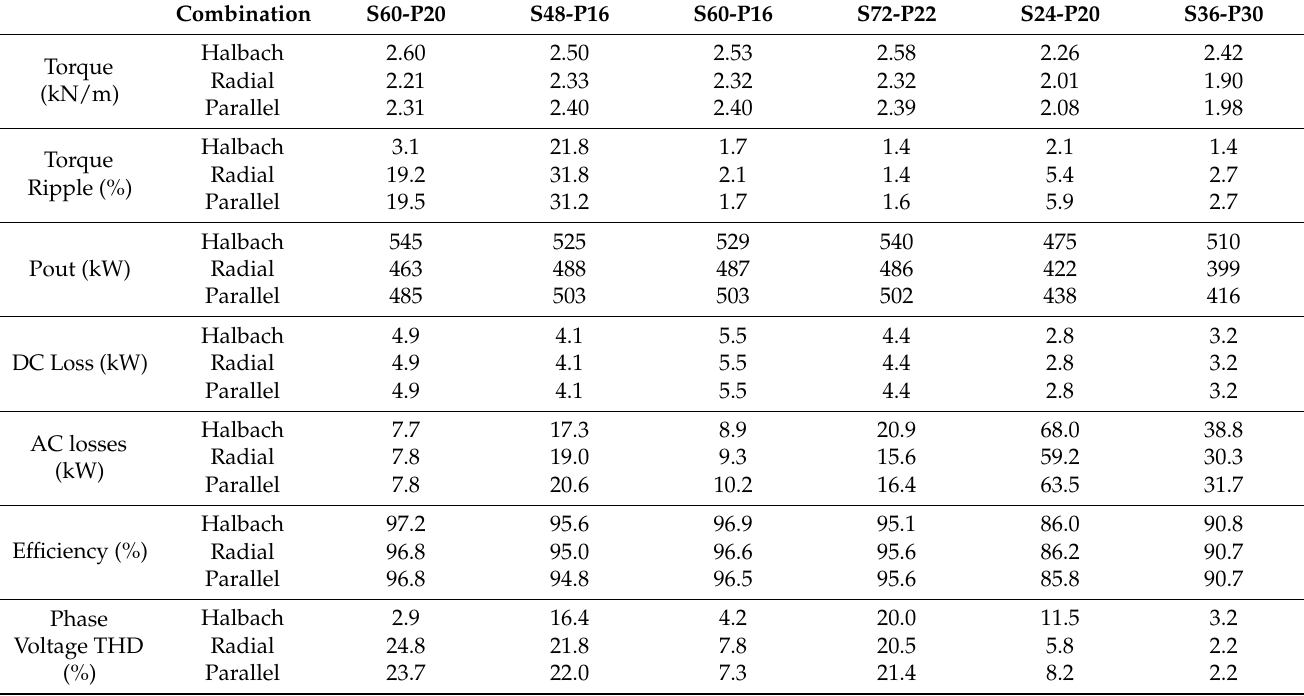
Table 2. PM magnetisation analysis results for AC losses